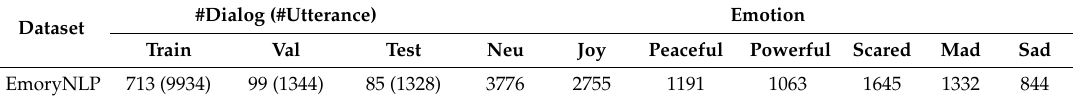
Table 2. Detailed descriptions of